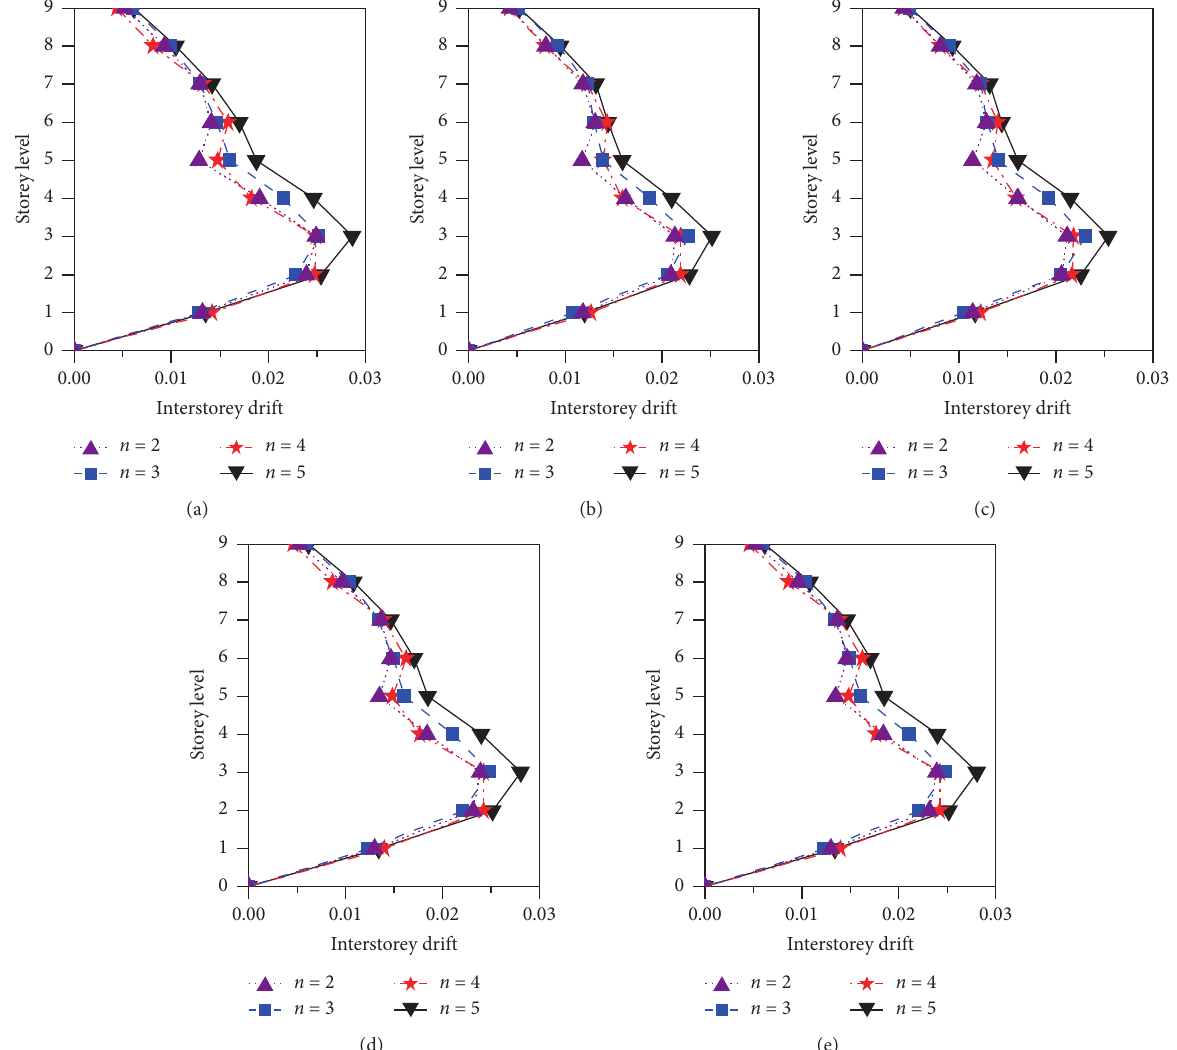
Figure 22: The interstorey drift of building-damper systems subjected to ANEs with different pulse numbers. (a) BRB. (b) FD. (c) SCD. (d) VD. (e)